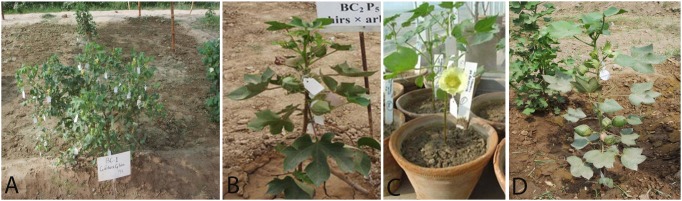
Hybrid Progenies of (G. hirsutum×G. arboreum).A = BC1; B, C = BC2; D = BC3.